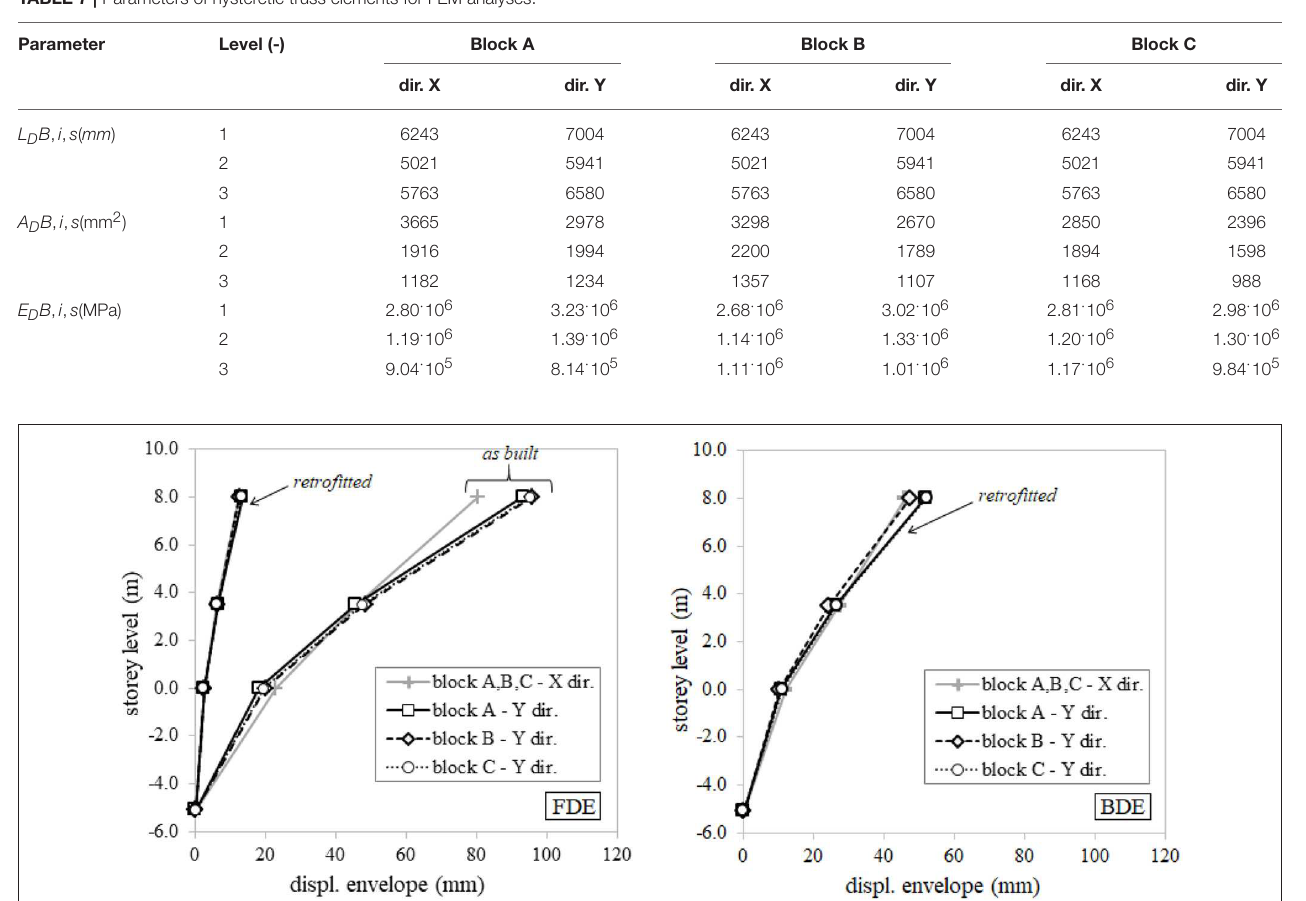
TABLE 7 | Parameters of hysteretic truss elements for FEM analyses. Parameter Level (-) Block A Block B Block C dir. X dir. Y dir. X dir. Y dir. X dir. Y